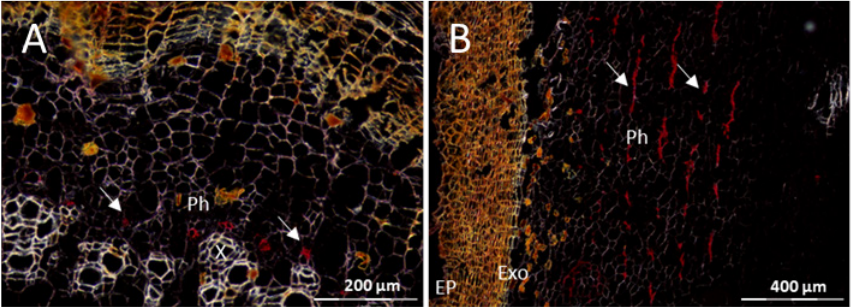
Figure 9. Distribution of CBSV-Mo83 RNA in cross sections of cassava DSC 260 tuberous roots. Red dots indicate viral RNA in phloem cells only (( A , B ); white arrows). X, xylem; Ph, phloem; Ep, epidermis; Exo, exodermis.